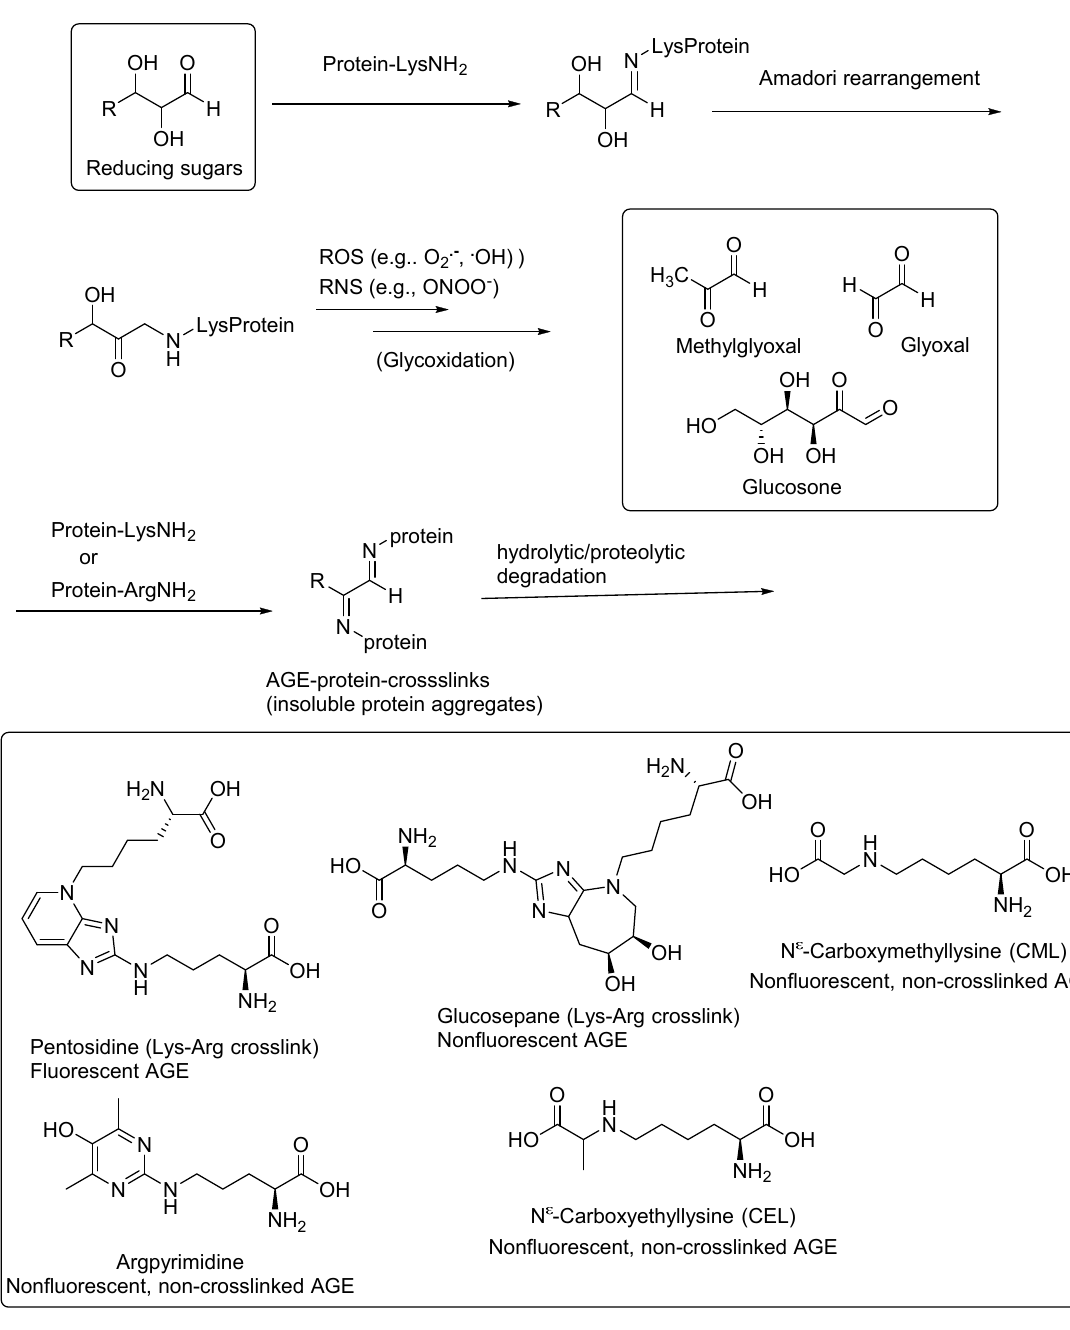
Figure 1. Formation of AGEs through nonenzymatic reactions of reducing sugars with protein amino groups.